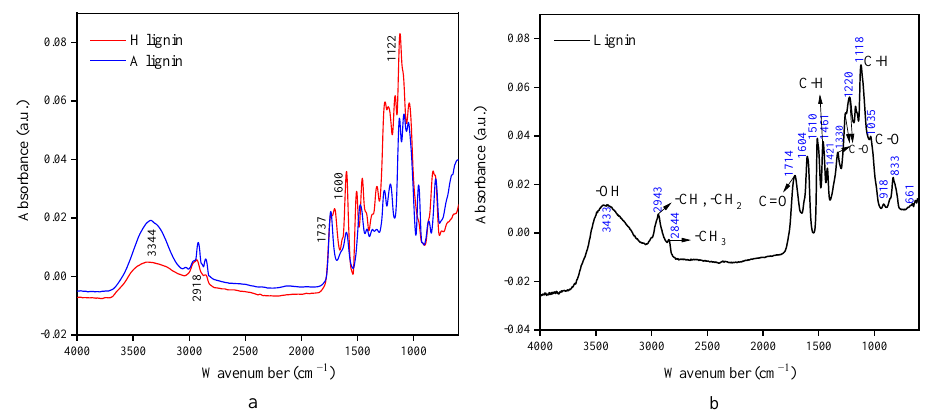
Figure 6. Infrared spectra of alkaline lignin AL and hydrothermal lignin HL separated by L-DES after alkaline pre-extraction and hydrothermal pre-extraction ( a ) and cellulase lignin ( b ). Cellulase lignin is extracted by solubilizing cellulose and hemicellulose using cellu- lase enzymes, and its structure is the most similar to the original natural lignin structure.